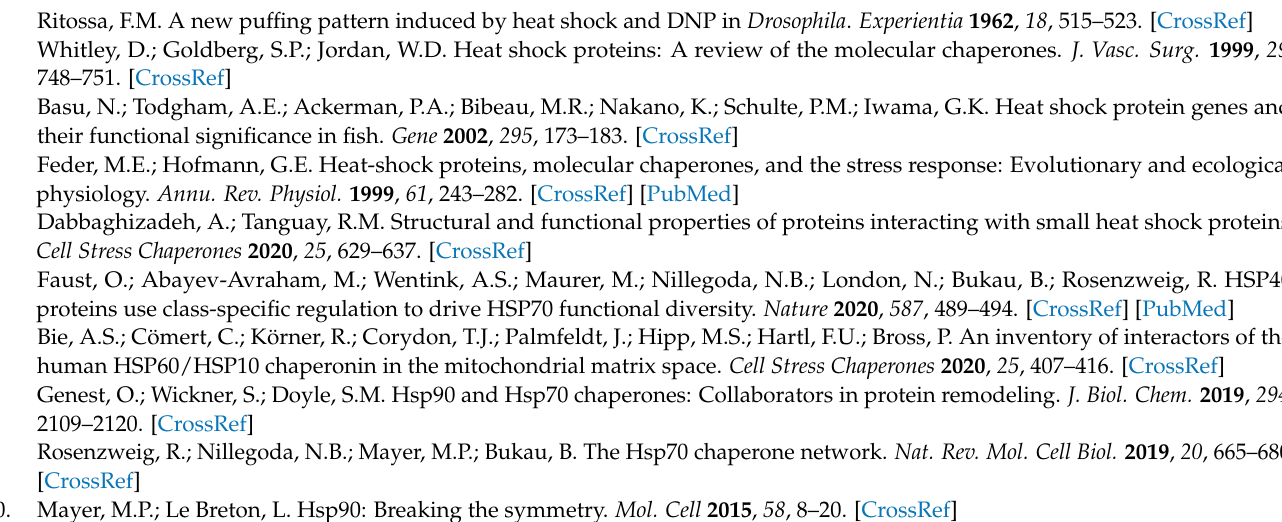
genes; Table S3: Differential expression of LmHsp s under salinity change and alkalinity stress by edgeR analysis; Table S4: Trend analysis for the LmHsp40-70-90 gene expression under alkalinity stress; Table S5: Protein-protein interaction (PPI) network for the LmHsp40-70-90 gene expression under alkalinity stress; Table S6: Molecular evolution analysis of the LmHsp genes among teleost lineages via PAML; Table S7: Branch-site model tests of the LmHsp genes with other teleost species via PAML; Figure S1: Principal component analysis (PCA) with FPKM values of all transcriptome samples under salinity change and alkalinity stress; Figure S2: Structure, motif and phylogeny of LmHsp families, showing phylogenetic relationship along with their conserved motifs. ( A ) LmsHsp s, ( B ) LmHsp40 s, ( C ) LmHsp10/60 s, ( D ) LmHsp70 s, ( E ) LmHsp90 s, and ( F ) LmHsp100 s. Abbreviations: Hsa: H. sapiens; Mmu: M. musculus; Gga: G. Gallus; Xtr: X. tropicalis; Loc: L. oculatus; Dre: D. rerio; Ipu: I. punctatus; Ola: O. latipes; Gac: G. aculeatus; Sma: S. maximus; Tru: T. rubripes; Oni: O. niloticus; Lca: L. calcarifer; Lma: L. maculatus ; Figure S3: Protein-protein interaction (PPI) of Hsp s from zebrafish and